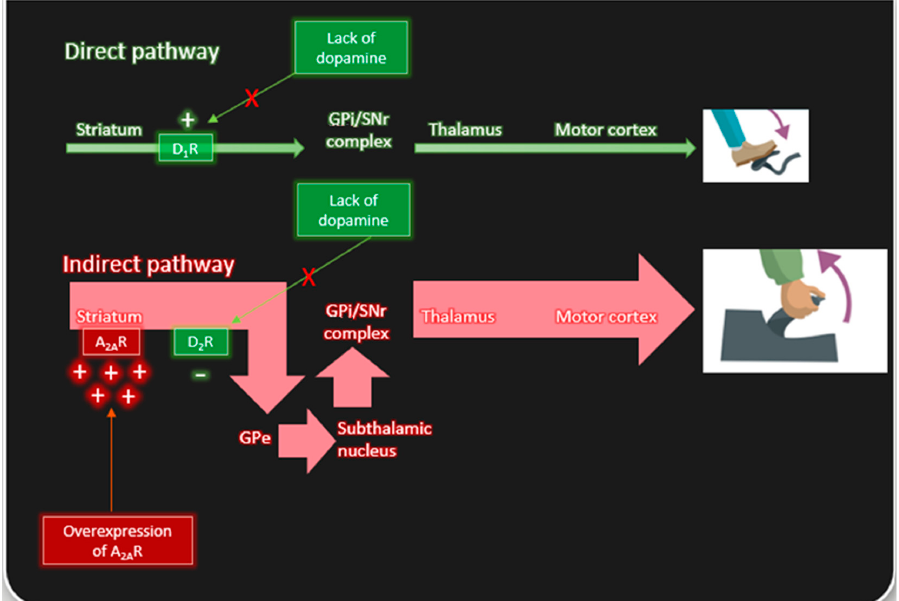
Figure 1. The direct and indirect pathways work together to control movement. The direct pathway expresses dopamine D1 receptors and relays motor signals from the dopaminergic neurons of the striatum through the globus pallidus internal (GPi) and substantia nigra pars reticulata (SNr) to relieve the inhibition of the thalamus and signal to the motor cortex to initiate movement. In this way, dopamine signaling in the direct pathway functions like the “gas” powering a car. The indirect pathway functions to control unwanted movement and functions like the “brake” in a car. Neurons of